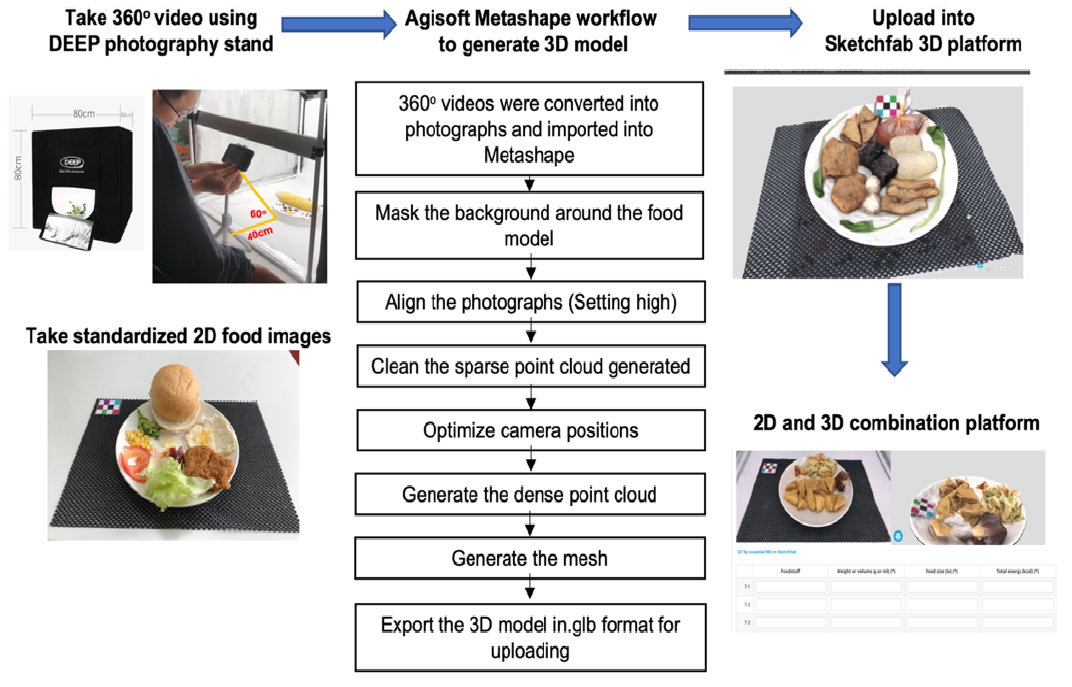
Figure 2. Study flowchart of educational integration of digital food models into a nutritional practicum course .